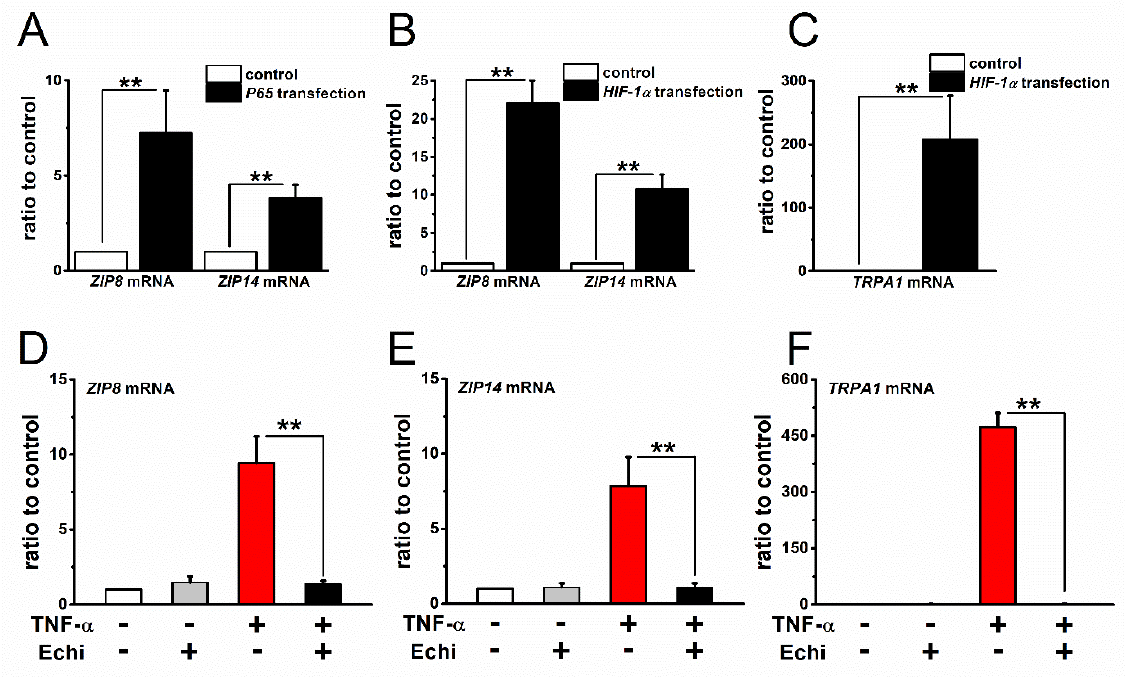
Figure 6. Expression of Zn 2+ transporters in FLSs and involvement of transcriptional factors NF- κ B and HIF-1 α in inflammatory induction. ( A ) Expression of ZIP8 and ZIP14 mRNA in FLSs transfected with and without a P65 expression vector (mean ± SEM; four independent experiments; ** p < 0.01). ( B ) The expression of ZIP8 and ZIP14 mRNA in FLSs transfected with and without an HIF-1 α expression vector (mean ± SEM; three independent experiments; ** p < 0.01). ( C ) As a control, the mRNA expression of TRPA1 was also compared in FLSs with and without HIF-1 α expression vector (mean ± SEM; three independent experiments; ** p < 0.01). Effects of Echi (1 µ M) on the induction of ( D ) ZIP8 , ( E ) ZIP14 , and ( F ) TRPA1 mRNA in FLSs stimulated with TNF- α . FLSs were treated with and without 10 U TNF- α for 24 h and the mRNA transcripts of ZIP8, ZIP14, and TRPA1 were compared. Echi treatment was performed for 24 h with and without TNF- α (mean ± SEM; four independent experiments; ** p <